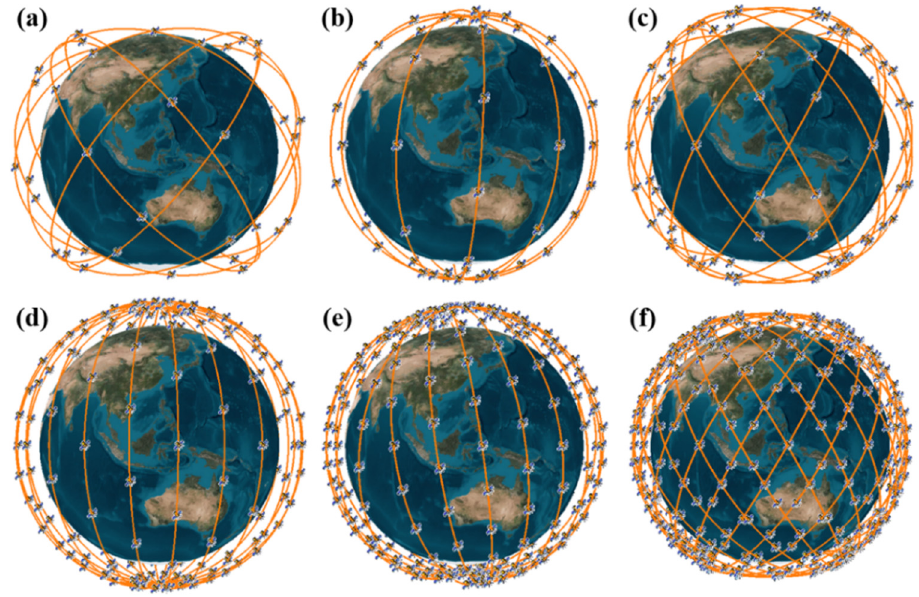
Figure 4. Designed LEO constellations: ( a ) 48 LEO, 1414 km, walker; ( b ) 66 LEO, 778 km, polar; ( c ) 120 LEO, 1000 km, walker; ( d ) 192 LEO, 1200 km, polar; ( e ) 288 LEO, 1000 km, polar; ( f ) 576 LEO, 900 km, walker.